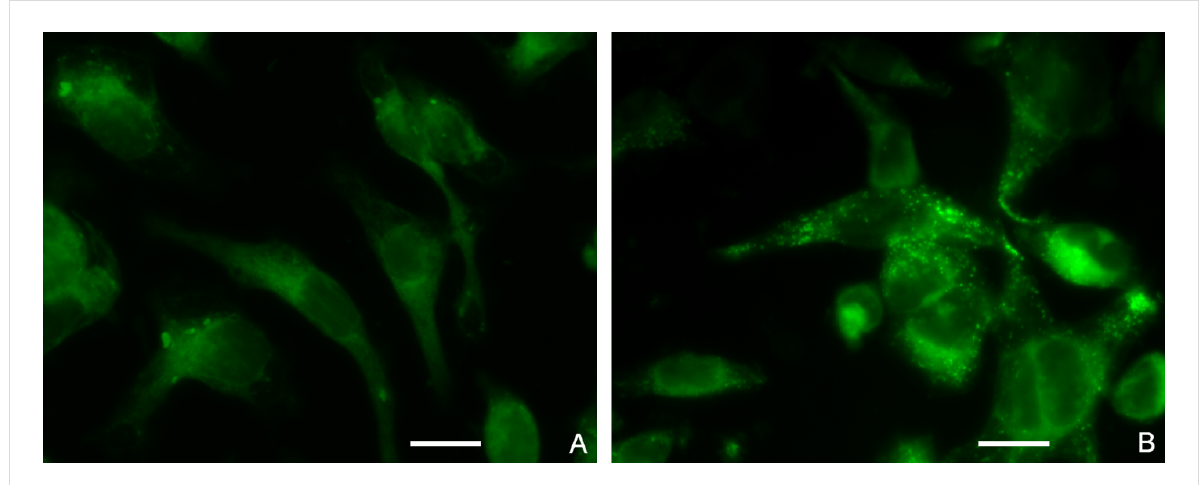
Figure 1: Subcellular localization of free IR820 (A) and IR820-PGMD NPs (B) in SKOV-3 after 24-hour incubation. Scale bar represents 20 µm.